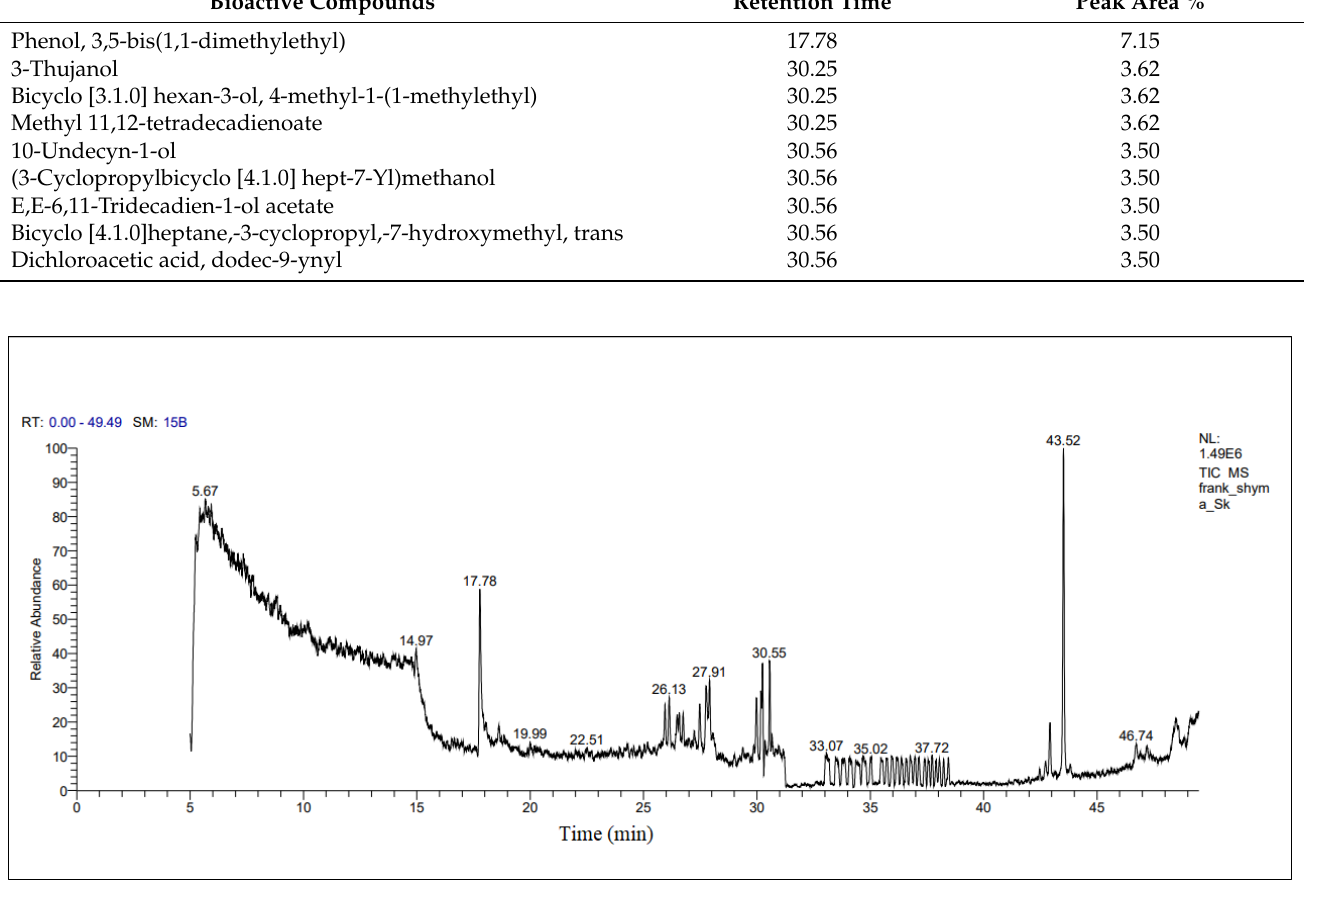
Figure 1. Chromatographic Characteristics of FO Compounds.